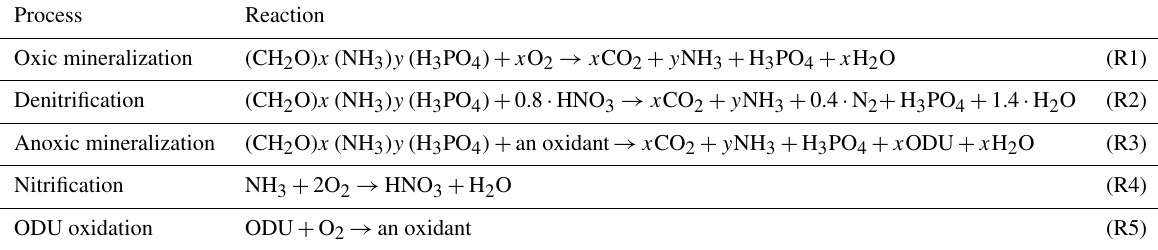
Table 1. Diagenetic reactions used in OMEXDIA. x denotes the molar C:P ratio and y the molar N:P ratio in organic matter per mole of phosphorus (for Redfield stoichiometry, x = 106, y = 16).